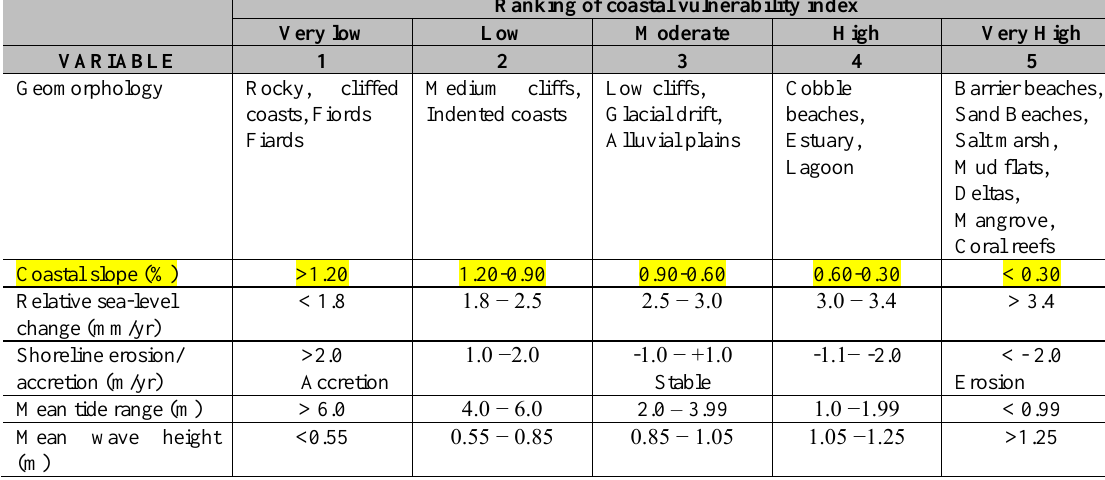
Table 2. Ranges for vulnerability ranking of variables along the Northern Gulf of Mexico Coast (Pendleton et al ., 2010) Ranking of coastal vulnerability index Very low Low Moderate High Very High VARIABLE Geomorphology Rocky, cliffed Medium cliffs, Low cliffs, Cobble Barrier beaches, coasts, Fiords Indented coasts Glacial drift, beaches, Sand Beaches, Fiards Alluvial plains Estuary, Salt marsh, Lagoon